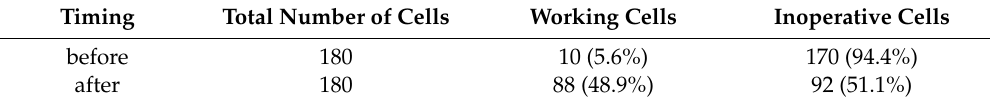
Table 4. Condition of the photocells before and after the 10 modules were